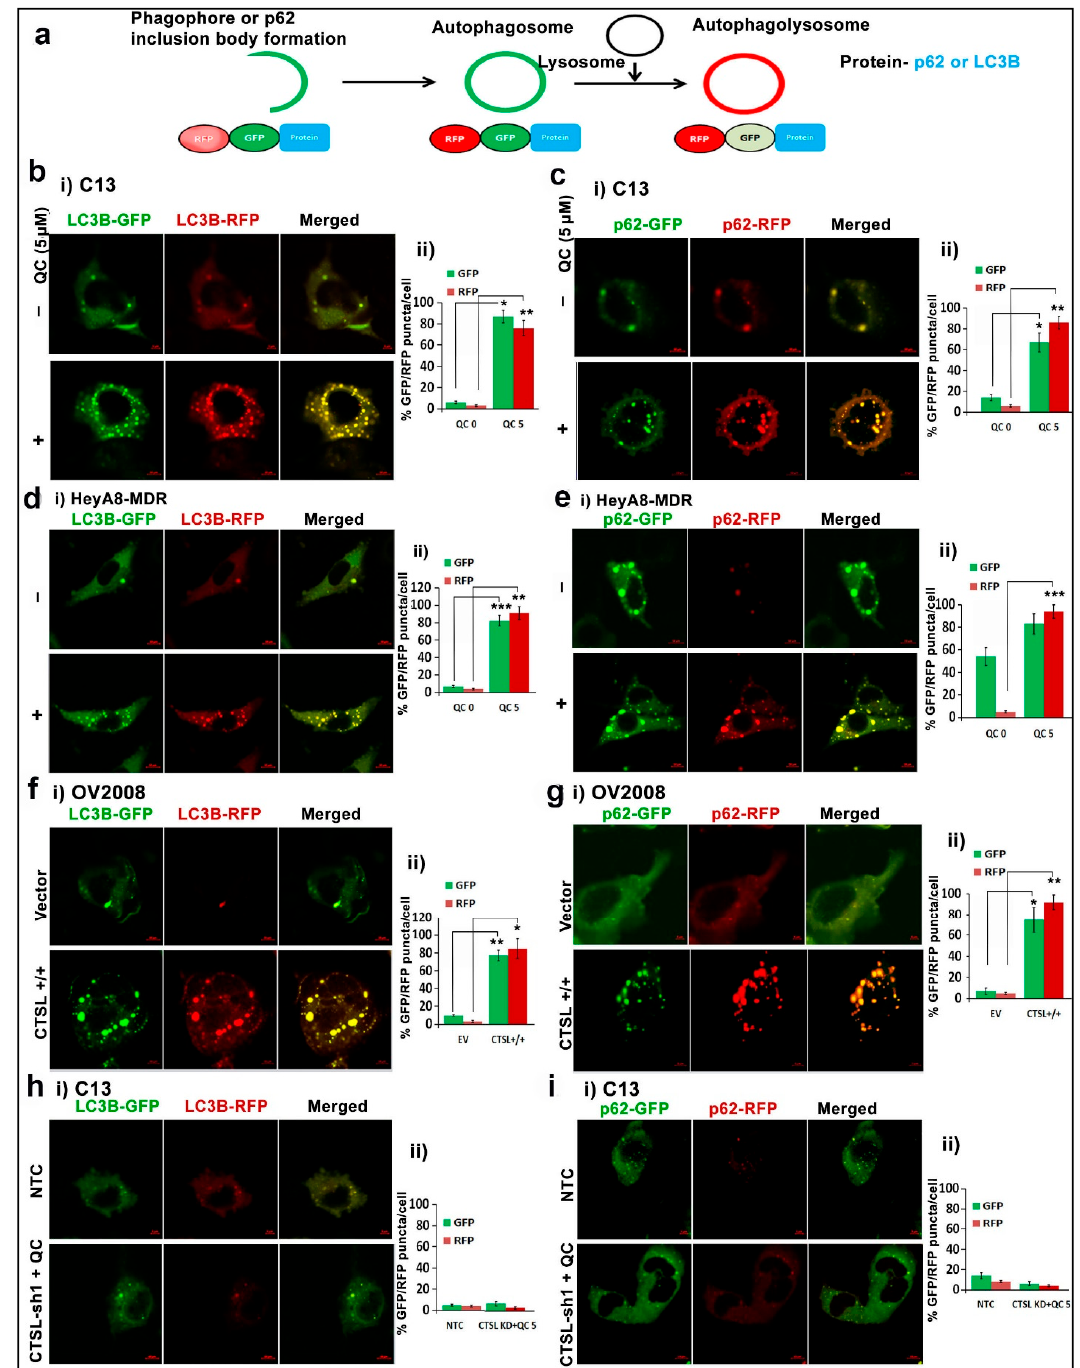
Figure 4. QC augments CTSL-mediated autophagic flux. ( a ) Double RFP-GFP tags were fused to LC3B or p62. QC increases autolysosomes (GFP+/RFP+ or RFP+) in ( b ( i ) and c ( i )) C13 cells transiently transfected with GFP-RFP-LC3B/or p62 plasmid, and ( b ( ii ) and c( ii )) their respective pictographs shows quantification of GFP/RFP positive autolysosome puncta per cell in C13. QC augments autolysosomes (GFP+/RFP+ or RFP+) in ( d ( i ) and e ( i )) HeyA8-MDR cells transiently transfected with GFP-RFP-LC3B/or p62 plasmid, and ( d ( ii ) and e ( ii )) their respective pictographs shows quantification of GFP/RFP positive autolysosome puncta per cell in HeyA8-MDR. Similar analysis was performed in the ( f ( i ) and g ( i )) OV2008 cells (vector and CTSL +/+ ) and ( h ( i ) and i ( i )) C13 (NTC, sh1) and ( f ( i )– i ( i )) their respective bar graphs depict quantification of GFP/RFP positive autolysosome puncta per cell in OV2008 and C13 cells, respectively (scale bar 10 µ m and 40 × magnification). Significance was expressed as * p < 0.05, ** p < 0.01, *** p < 0.001. Abbreviations: CTSL: Cathepsin-L; LC3B: Light Chain 3B; p62: Ubiquitin binding Protein 62 and RFP/GFP: Red/green fluorescent